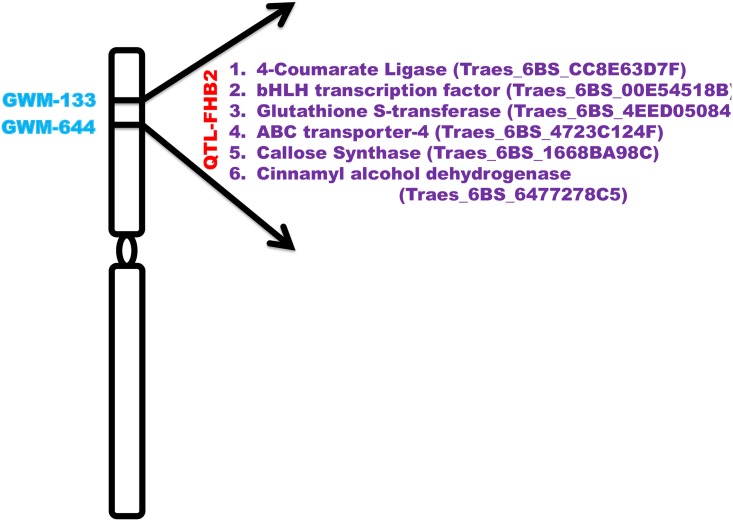
Wheat chromosome 6B, depicting the physical location of QTL-Fhb2 (marked red), on short arm of the chromosome 6B, flanked by two SSR markers GWM-133 and GWM-644 (marked blue).The genes localized within the QTL locus were identified using metabolo-transcriptomics approach, which are shown within two arrow marks, marked purple in text. The corresponding gene Ids are given in parenthesis.